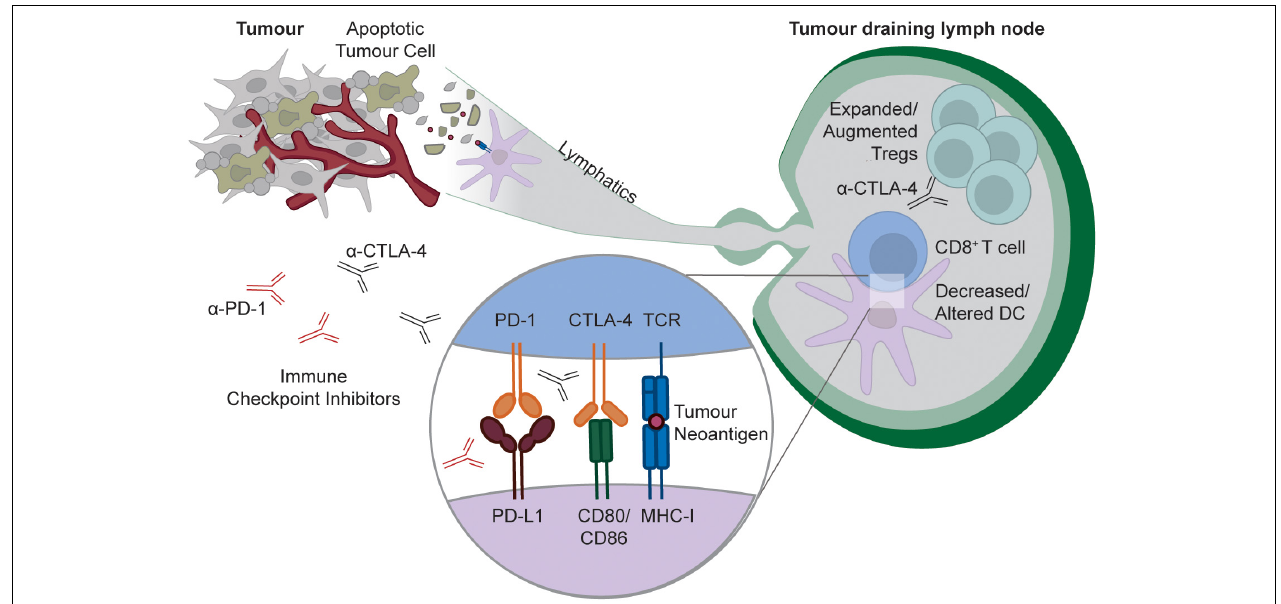
FIGURE 3 | Targeting peripheral tolerance to tumor antigens by checkpoint blockade. As with any self-tissue, tumors can constitutively release cellular debris containing tumor neo-antigens (likely downstream of apoptotic cell death), and these antigens can be captured by DCs for presentation to naïve CD8 + T cells within the tumor draining lymph node. In some tumors, tumor antigen presentation is tolerogenic, either because tumors insufficiently activate the innate immune system, or because tumors actively modulate the lymph node environment to limit immunity by decreasing or altering DCs, and/or increasing or augmenting Tregs. Checkpoint blockade with α -PD-1 or α -CTLA4 can disrupt this tolerance process by either interfering with the delivery of negative signals to the T cell by the DC, or, in the case of CTLA-4 blockade, through active Treg targeting and